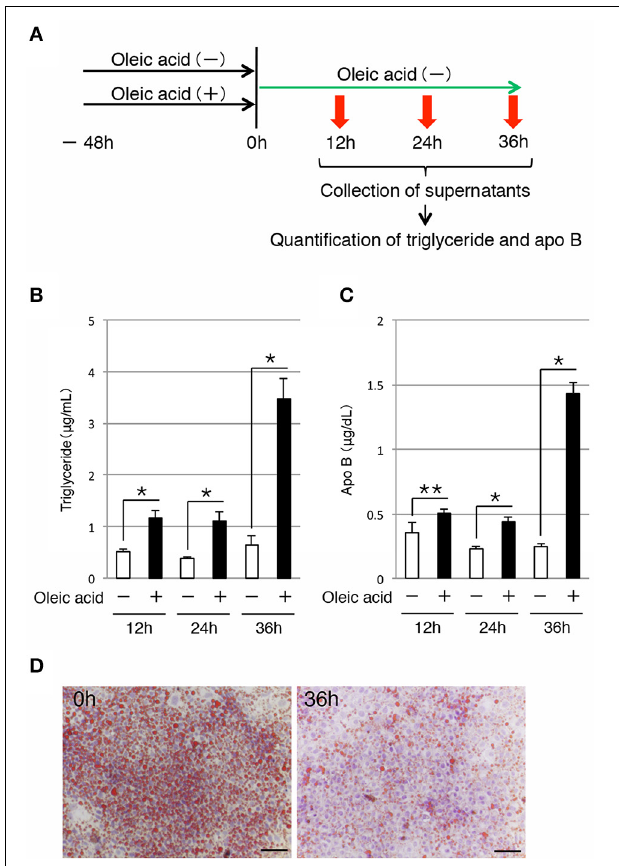
FIGURE 3 | iHep cells have the ability to secrete triglyceride and apo B. (A) Schematic diagram of the experimental procedure. iHep cells were cultured with or without oleic acid for 48h, and then cultured for 36h after changing the culture medium. The supernatants were collected at 12, 24, and 36h after changing the culture medium, and the amounts of triglyceride and apo B in the supernatants were measured. (B,C) Quantification of triglyceride (B) and apo B (C) contents in the supernatants collected at 12, 24, and 36h after changing the culture medium. The amounts of triglyceride and apo B in the supernatants were normalized to the values per 1 × 10 4 cultured cells. The graphs show the average of three independent experiments (mean ± SD). ∗ P < 0 . 01, ∗∗ P < 0 . 05 (Student’s t - test). (D) Oil red O staining was conducted for iHep cells at 0 and 36h after changing the culture medium. DNA was stained with hematoxylin. Scale bars, 50 μ m.